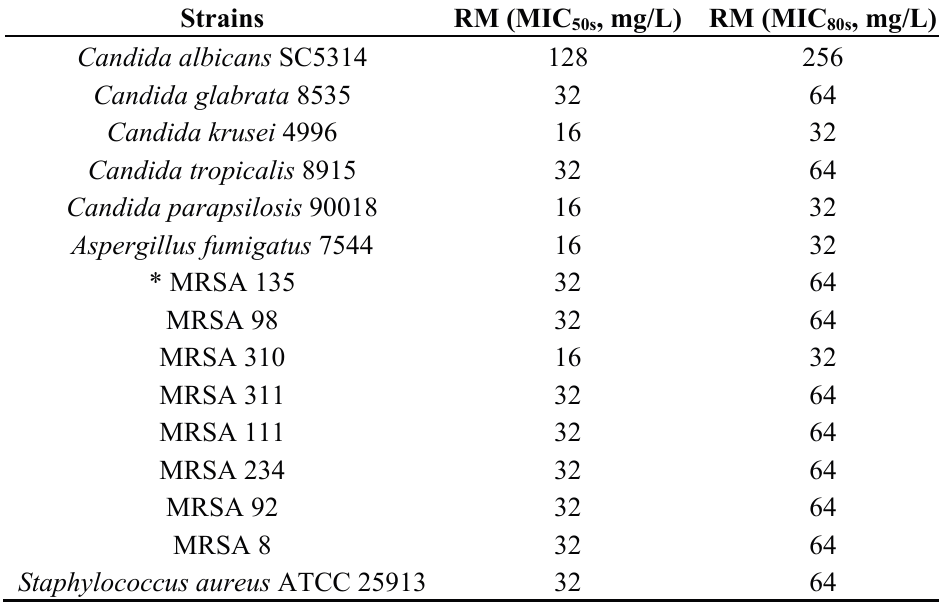
Table 1. The antimicrobial spectrum of RM (MIC 50s and MIC 80s in